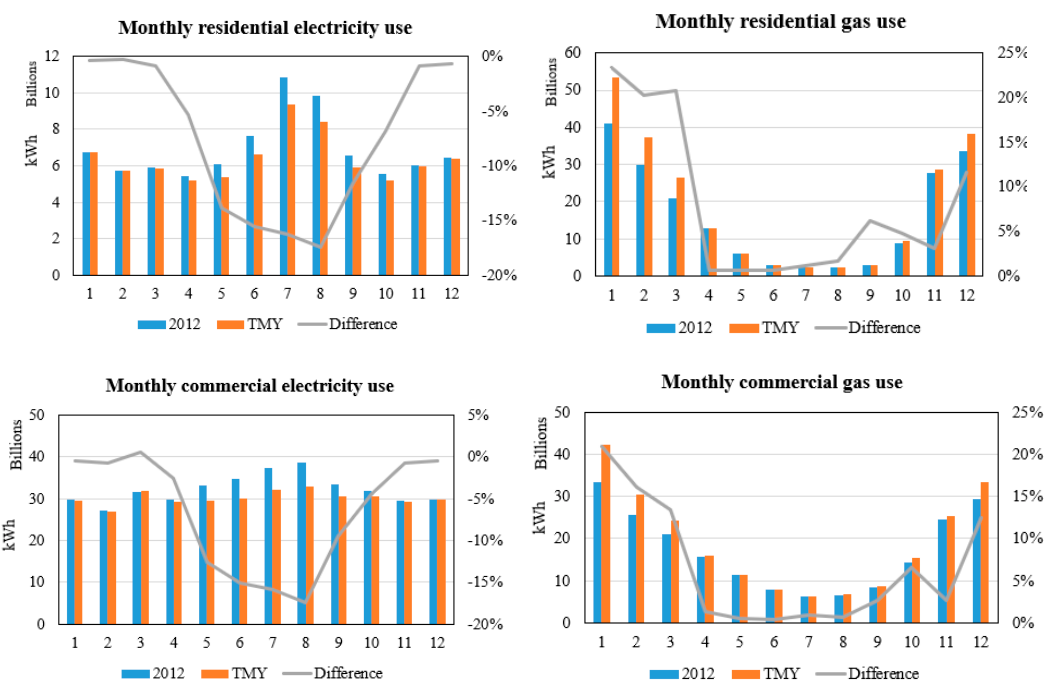
Figure 12. Comparative analysis of the modeled energy use by using localized weather data and TMY weather data.